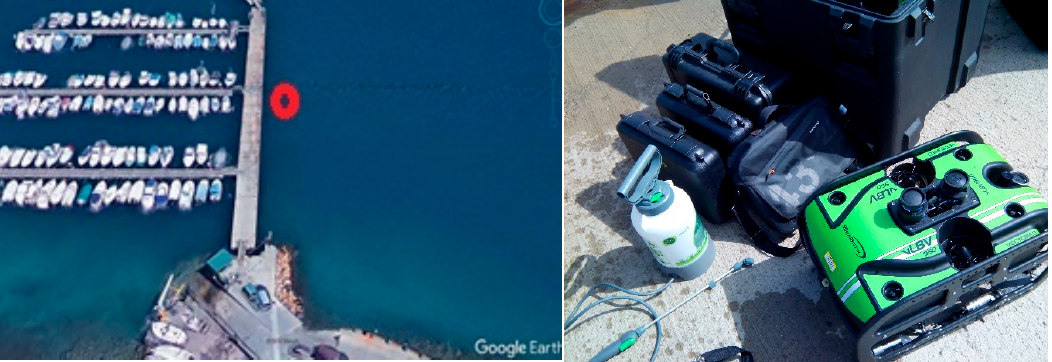
Figure 1. Deployment point inside the port ( left ) and one of the robotic equipment used ( right ).